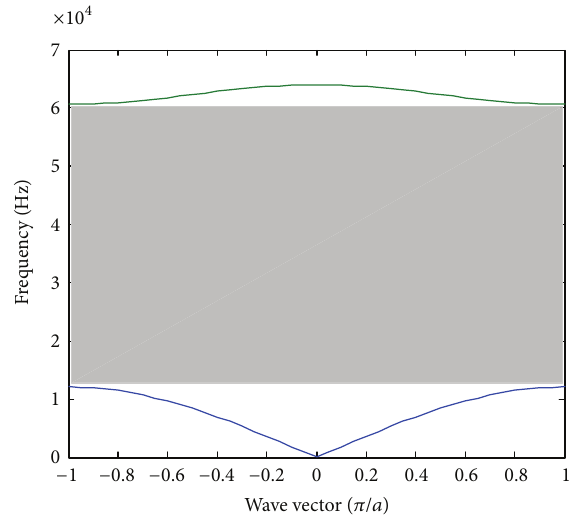
Figure 7: Band structure (steel-epoxy